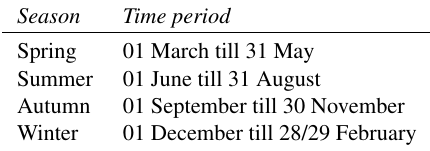
Table 1. Meteorological seasons as defined for the northern